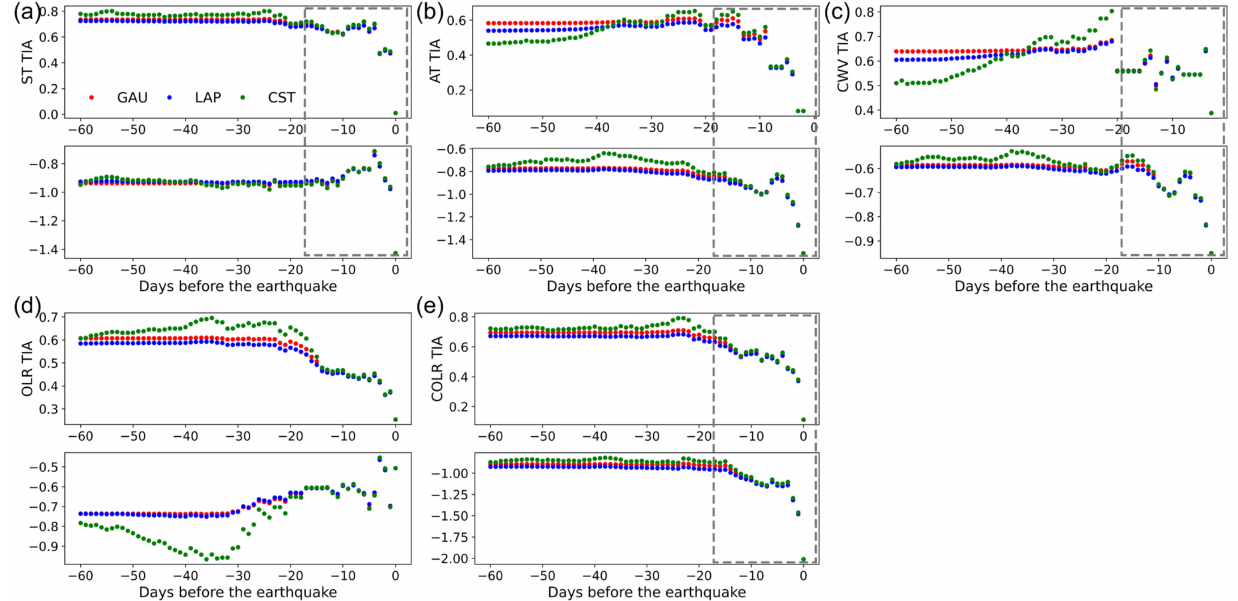
Figure 3. Trend characteristics for multiparametric temporal integrated anomalies (TIAs) before the 2011 M9.1 Great Tohoku Earthquake, Japan, demonstrating enhanced negative TIAs close to earth- quake occurrence. ( a ) Skin temperature (ST) TIA; ( b ) air temperature (AT) TIA; ( c ) total integrated column water vapor burden (CWV) TIA; ( d ) outgoing longwave radiation (OLR) TIA; ( e ) clear-sky OLR (COLR) TIA. The two subfigures for each anomaly show the positive and negative TIAs, re- spectively. Negative days at the abscissa denote the days before the earthquake. The gray dashed frame indicates the TIA trend characteristics. The red, blue, and green dots denote Gaussian (GAU), Laplace (LAP), and Constant (CST) weight integration functions,